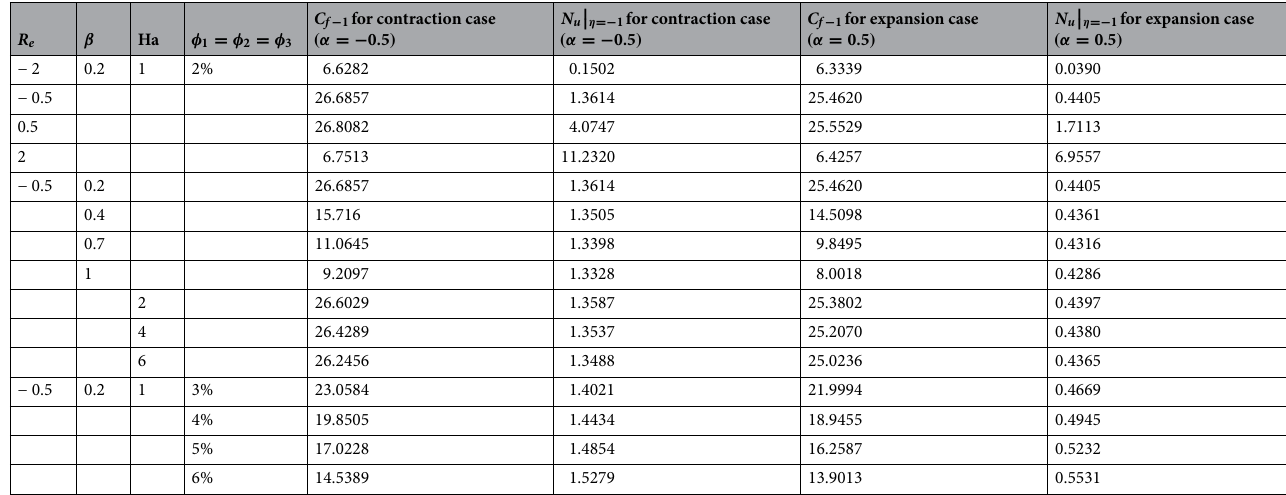
Table 5. The impact of R e , β , Ha, φ 1 , φ 2 , and φ 3 on the SFC and Nusselt number for contraction and expansion 1, S 3, R d 1, N 1 1. case, for R 0 = = = =